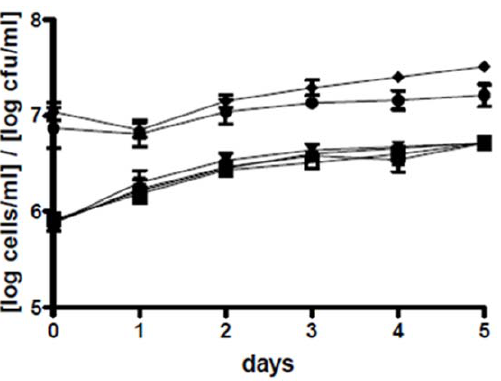
Figure 1. Concentrations of Tetraselmissuecica and Phaeobacter gallaeciensis in the co-cultures. Means and standard deviations of N eight experiments: colony-forming units of P. gallaeciensis wild type ), and concentrations of T. suecica ( ¤ ) and the TDA-negative mutant ( with V. anguillarum ( . ), T. suecica with P. gallaeciensis wild type ( & ), T. suecica with P. gallaeciensis TDA-negative mutant ( m ), and axenic T. suecica ( % ). The P. gallaeciensis strains were inoculated at 10 7 cfu/ml and remained as a steady population, while the algae went from late log into stationary phase.